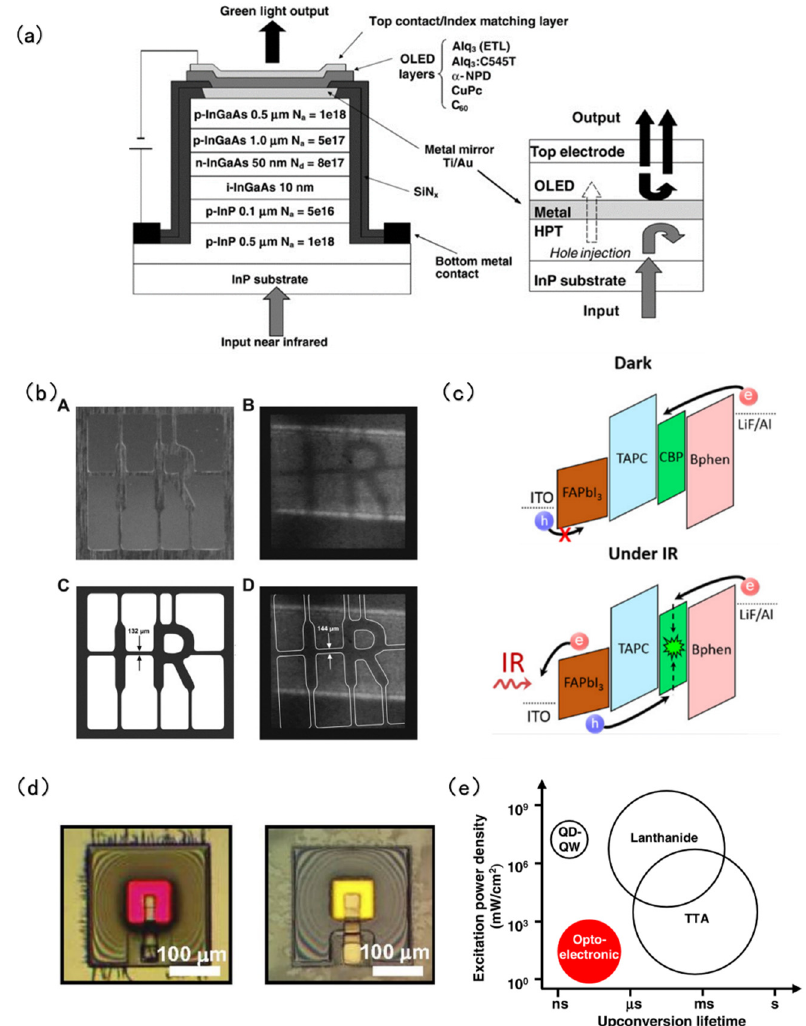
Figure 5. Structures and performance characterization of hybrid organic–inorganic NIR-to-visible upconversion devices. ( a ) Structure of the hybrid upconversion device with integrated InGaAs/InP HPT and OLED. The right picture demonstrates a highly reflective metal layer that inserts in the upconverter, and the embedded optical mirror could improve the absorption and emission effi- ciency [44]. Copyright 2010, Advanced Materials. ( b ) Picture A of the shaped aperture showing the letters “IR”. Picture B of the operating device at 10 V with NIR illumination through the aperture. Picture C is the shape aperture design showing the minimal feature size. Image D of the operating device is overlaid with the shape of the aperture indicating the minimum size of the captured function [45]. Copyright 2012, Advanced Material. ( c ) Band diagram and working mechanism of the upconversion device under the dark and under NIR illumination [46]. Copyright 2018, ACS Applied Materials & Interfaces. ( d ) Microscopic image of upconversion devices with red ( left ) and yellow ( right ) emissions under IR excitation [47]. Copyright 2018, PANs. ( e ) Lifetimes and typical